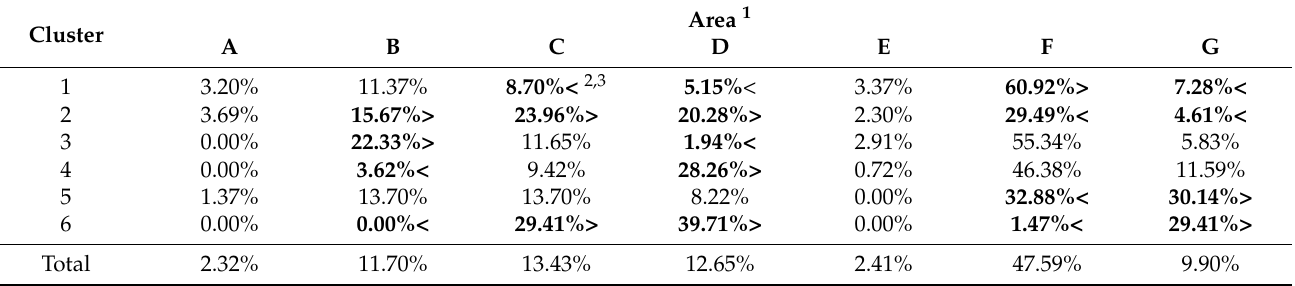
Table 10. Distribution clusters by area of reporting of sequences from clinical